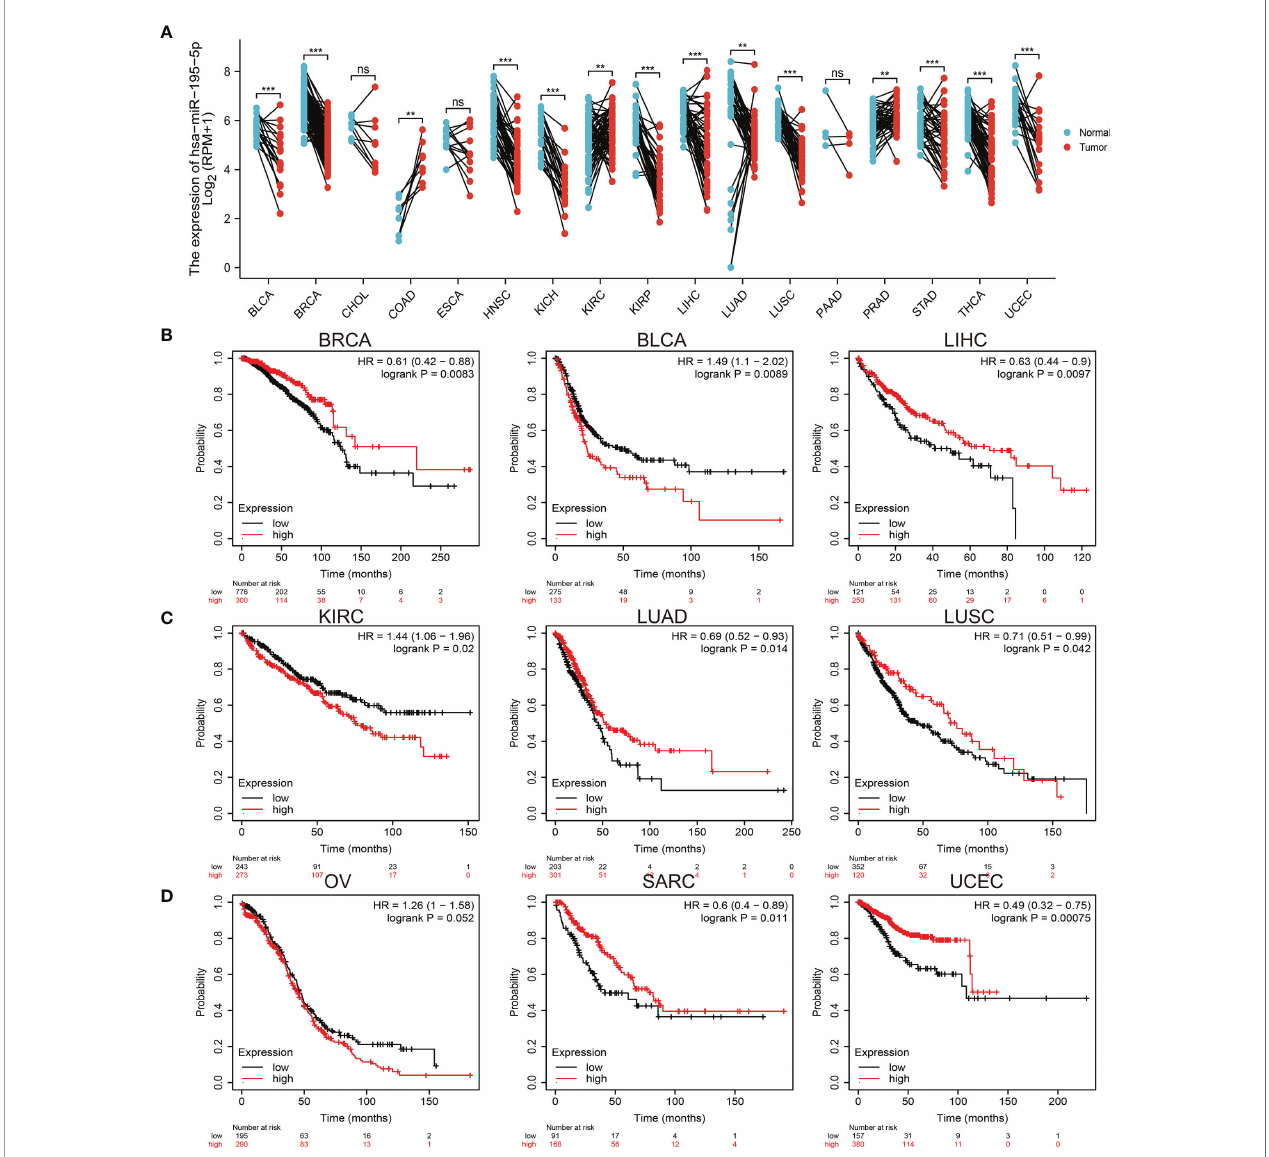
FIGURE 1 | Expression analysis for miRNA-195-5p in human cancers. (A) The expression of miRNA-195-5p in pan-cancer analysis by the starbase. (B – D) The overall survival of miRNA-195-5p in pan-cancer examine by the kmplot database. **P<0.01; ***P<0.001; NS, p >